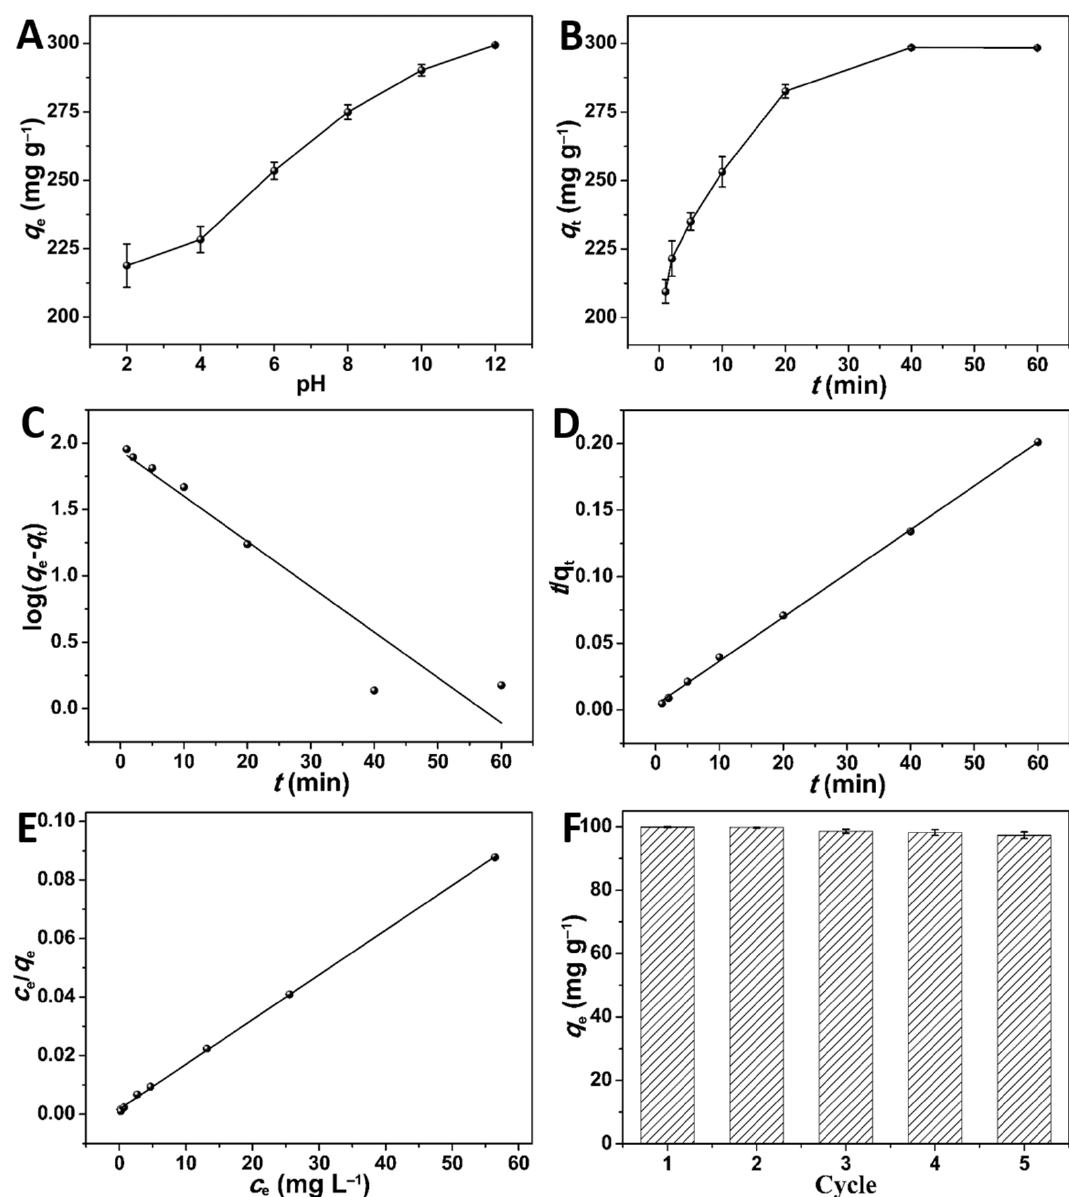
Figure 3. Effect of ( A ) pH ( c 0 : 300 mg L − 1 , 120 min, 25 °C), ( B ) adsorption time ( c 0 : 300 mg L − 1 , pH: 12, 25 °C), ( C ) PFO, and ( D ) PSO kinetics; ( E ) Langmuir isotherm and ( F ) reusability of MB adsorp- tion on SPVPC.